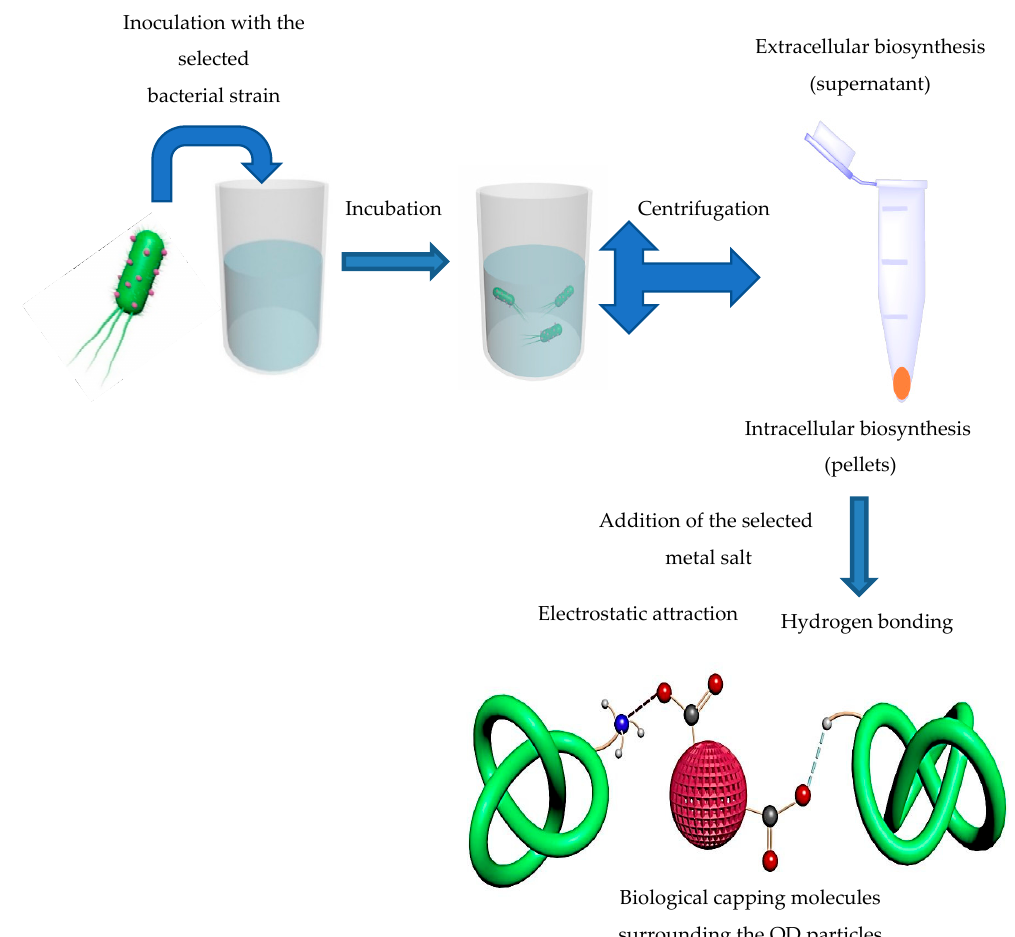
Figure 3. Extracellular and intracellular synthesis mechanisms of QD particles using